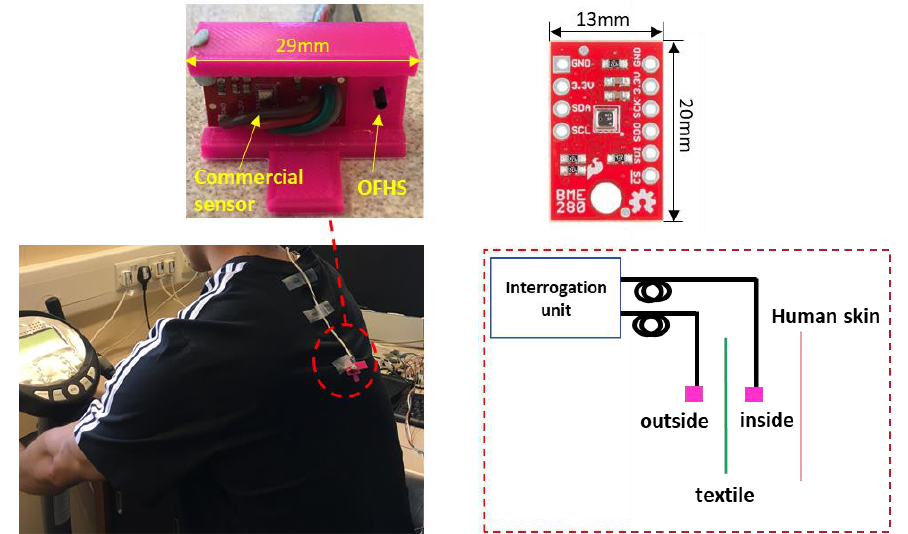
Figure 2. Humidity measurement in sports activity (cycling). Two pairs of sensors (BME280 and OFHS) were placed inside and outside of the garment respectively. BME280 and OFHS were embedded in a small 3D-printed holder for maintaining the same sensing direction.